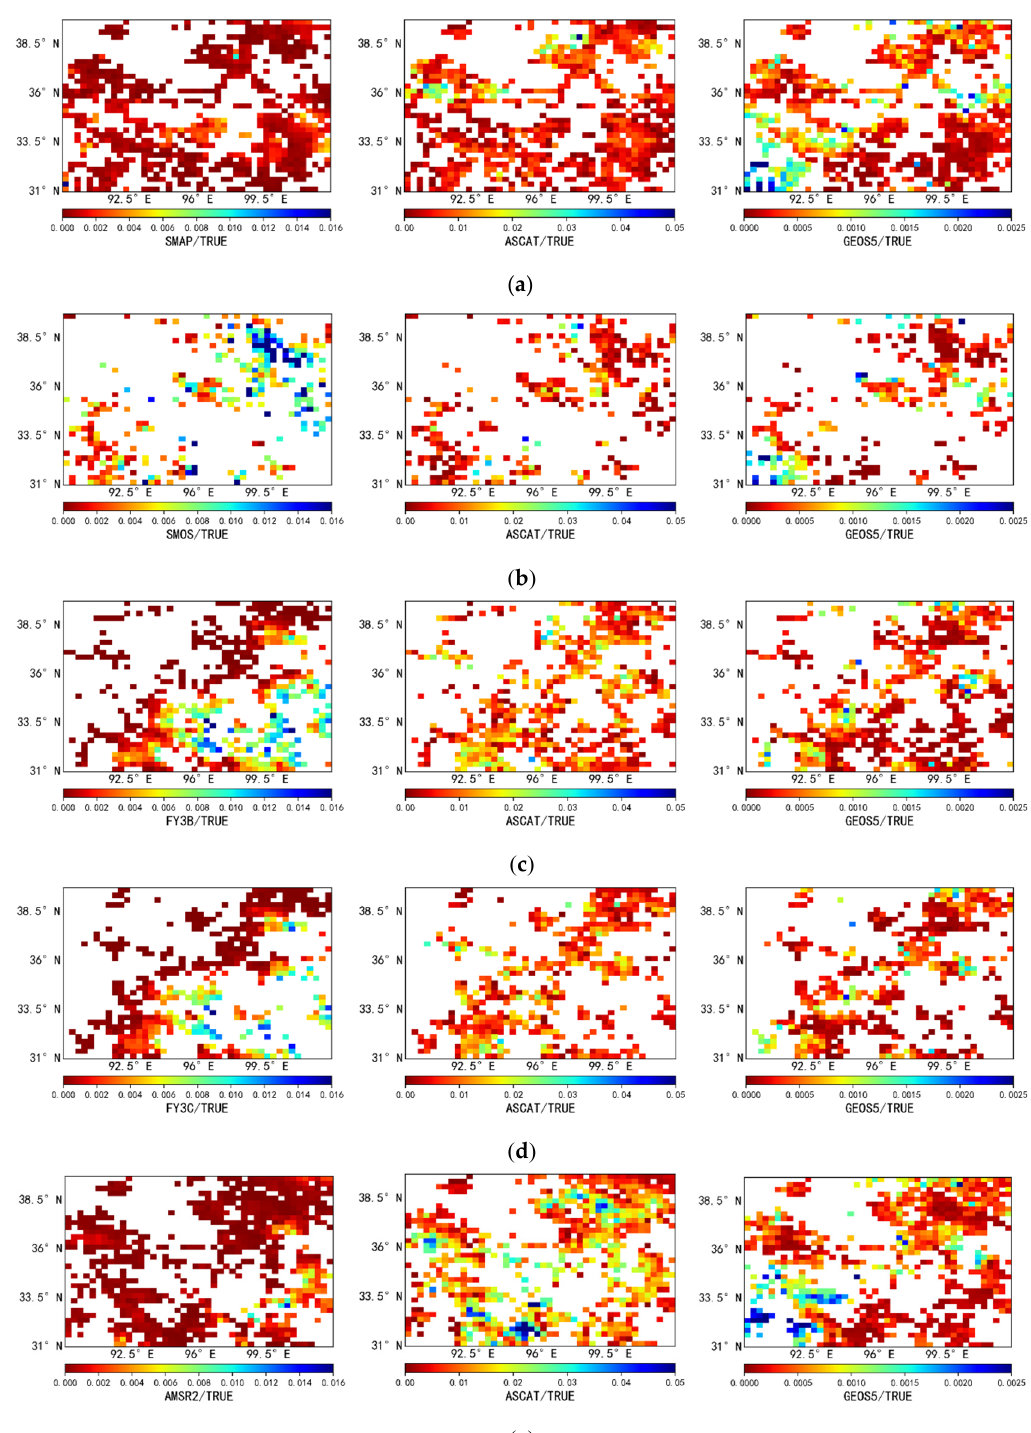
Figure 4. Spatial characteristics of the triple collocation (TC) error variance ( σ 2) in the study area. The five columns of sub-figures show, from top to bottom: ( a ) [SMAP, ASCAT, GEOS5]; ( b ) [SMOS, ASCAT, GEOS5]; ( c ) [FY3B, ASCAT, GEOS5]; ( d ) [FY3C, ASCAT, GEOS5]; ( e ) [AMSR2, ASCAT, GEOS5]. The three rows of sub-figures show, from left to right, the error variance between the passive and true soil moisture, the error variance between the active and true soil moisture, and the error variance between the reanalysis and true soil moisture.